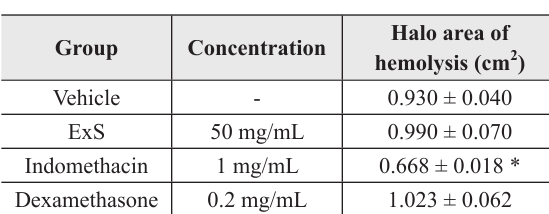
Effect of Streptoverticillium sp. extract (ExS), Indomethacin and Dexamethasone onphospholipase A enzymatic assay in 2